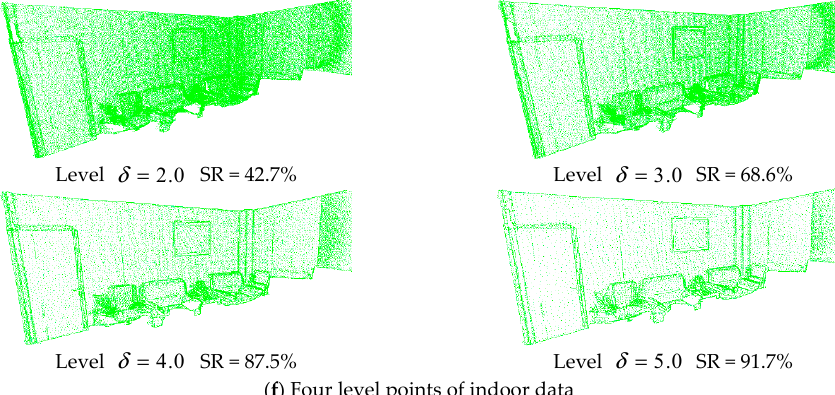
Figure 11. Multi-level points of experimental data.